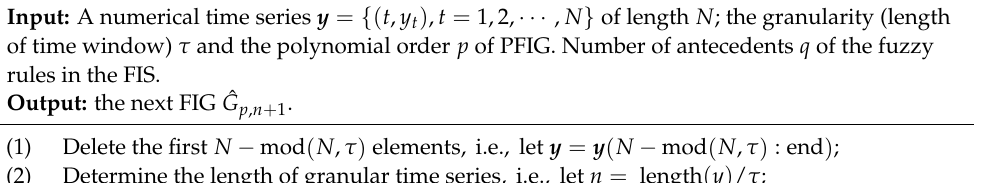
Algorithm 1: Time series prediction algorithm based on FIS and GPFIGs.